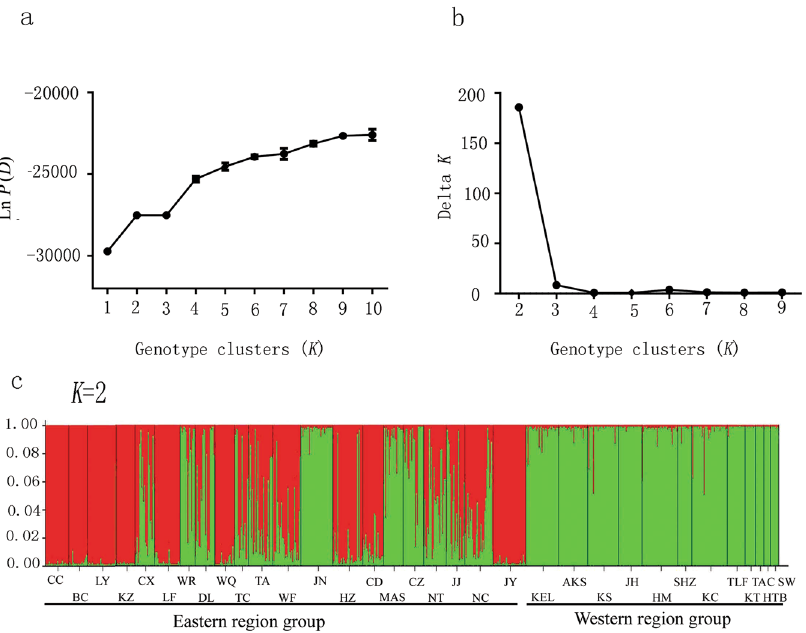
Figure 4. Bayesian inference to determine suitable cluster ( K ) and estimated cluster proportion using STRUCTURE for Aphis gossypii . The likelihood of the data given ln P ( D ) ( a ) and Δ K ( b ) are plotted against the number of genetic clusters ( K ). Error bars represent standard deviations over 10 runs. For the assignment proportion in all populations, each individual is represented by a thin vertical line, which was partitioned into K segments that represent its estimated population group membership fractions ( c ). Population codes are given in Table 2.